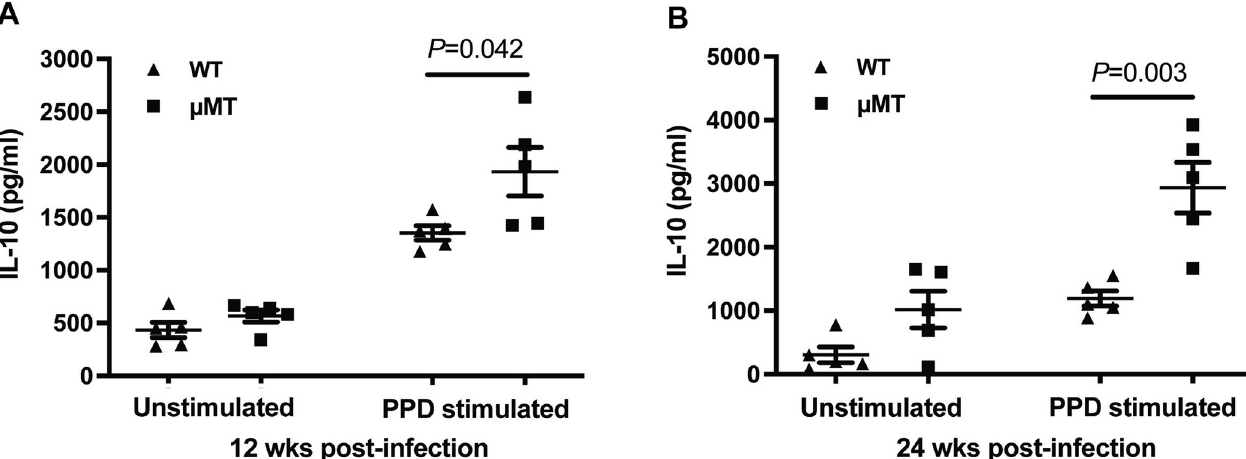
Fig 4. Increased IL-10 production by the lung cells of B cell-deficient μ MT mice during chronic infection with M . tuberculosis . Mice were aerogenically infected with a low dose (100 CFU) of M . tuberculosis Erdman. Ex vivo IL-10 production by lung cells isolated from B cell-deficient μ MT and WT control mice was evaluated at 12 weeks (A) and 24 weeks (B) after infection. Single-cell suspension of lung cells were cultured in complete RPMI with or without 10 μ g/ml of PPD (Statens Serum Institute, Copenhagen) at 1.0 x 10 7 cells per ml. After 48 hours of culture, supernatants were collected and subjected to detection of IL-10 as described in “Materials and Methods” section. The results revealed that the levels of expression of lung IL-10 in tuberculous μ MT mice are enhanced compared to that observed in WT animals. The data are depicted as mean ± SEM. The results shown in this figure are representative of two independent experiments; n = 4 to 5 mice per group per time